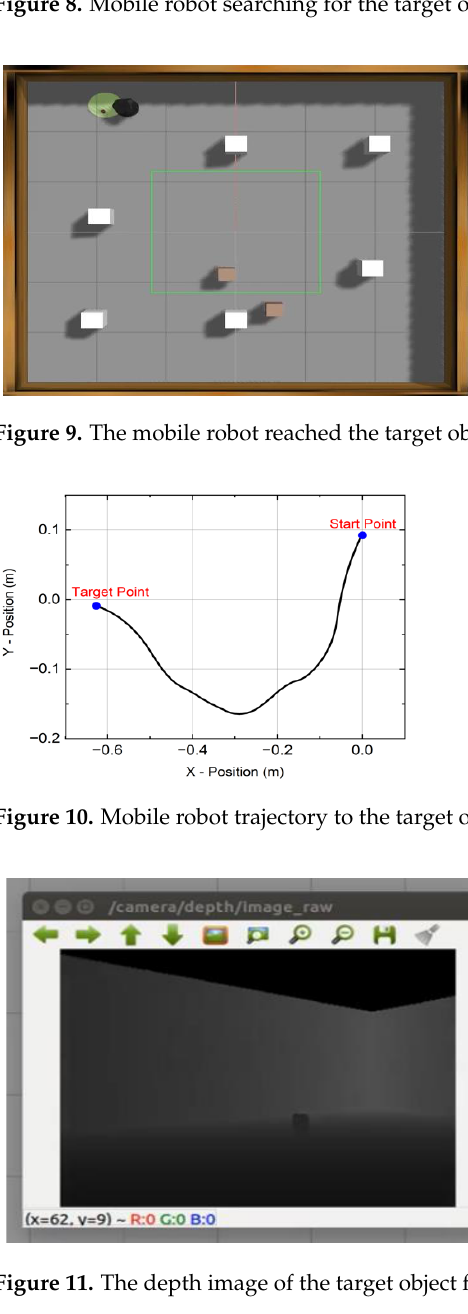
Figure 8. Mobile robot searching for the target object using a DQN agent.